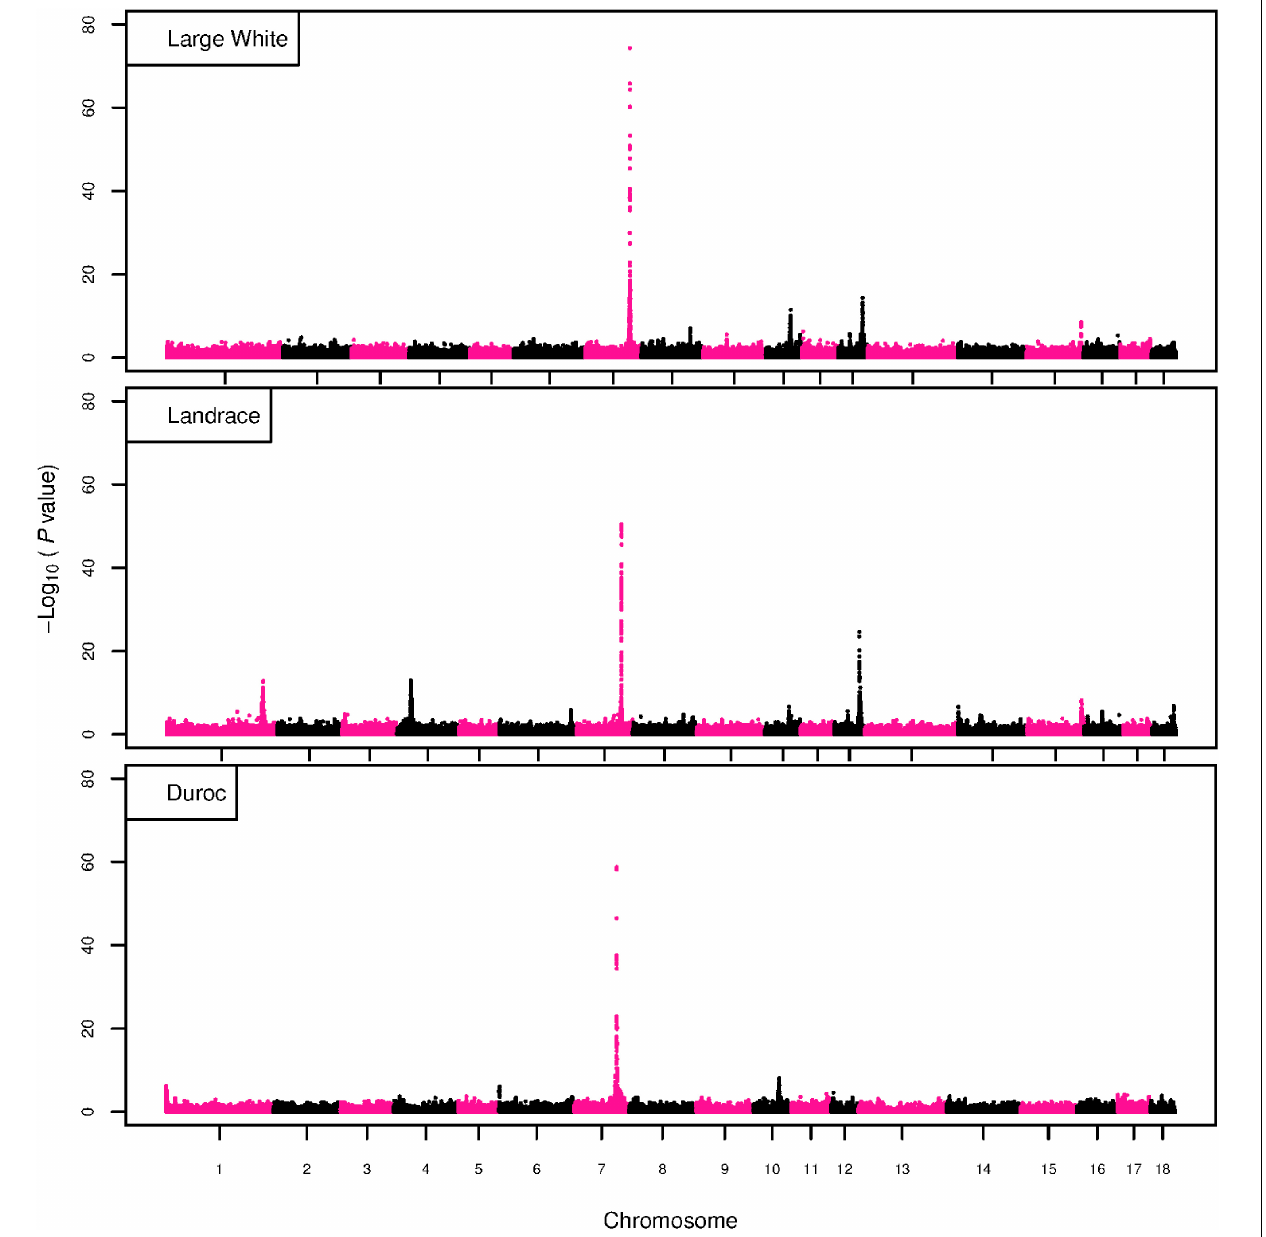
FIGURE 3 | GWAS plot for NTE with imputed 660K SNP chip data. On the y -axis is the –log 10 ( p -values) of single SNP association with NTE in LW, L, and D breeds. On the x -axis is the physical position of the SNP across the 18 autosomes.